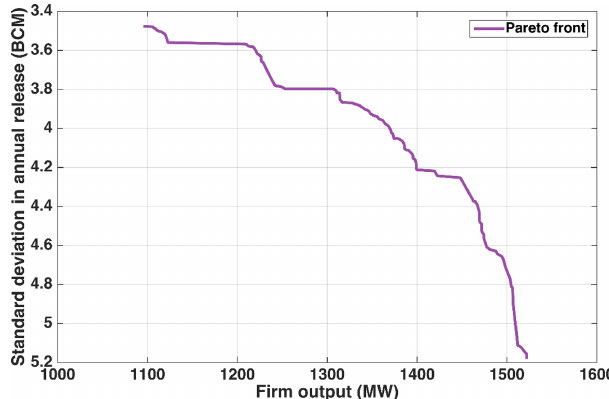
Figure A1. Pareto front for maximum firm output (90% guarantee) and minimum annual water release